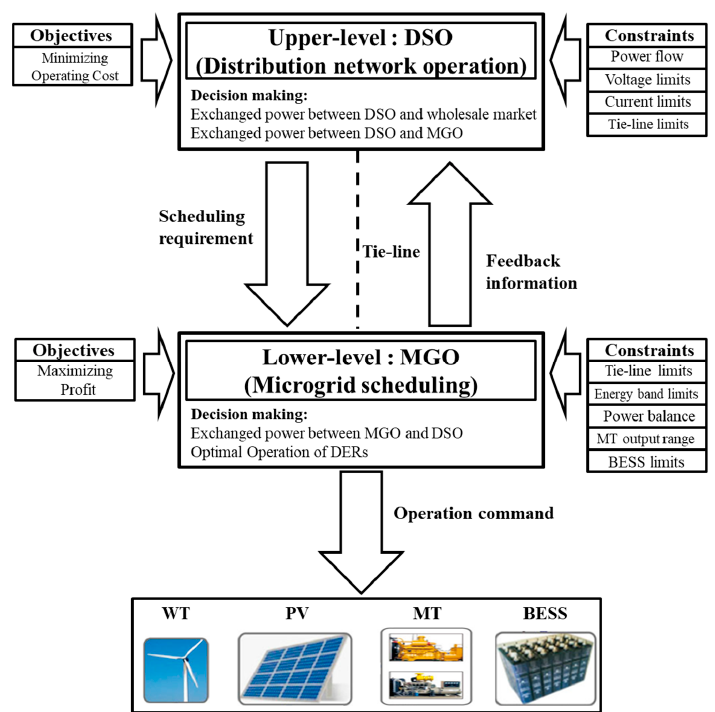
Figure 2. Overall scheme of a bi-level model. MGO: microgrid operator; DSO: distribution network operator; WT: wind turbine; PV: photovoltaic; MT: microturbine; BESS: battery energy storage system.